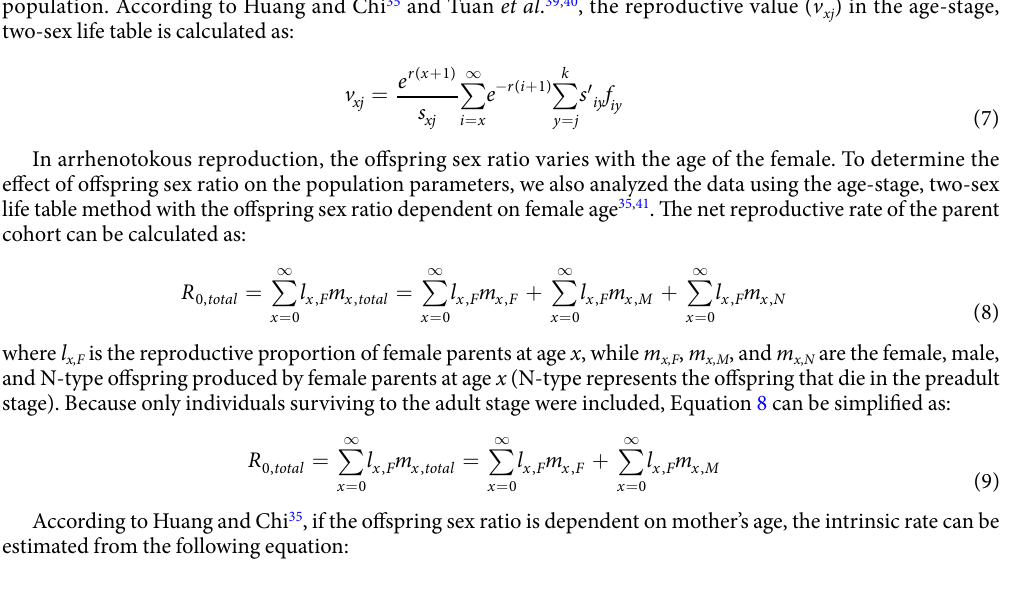
where ′ s is the probability that an individual of age x and stage j will survive to age i and stage y and is calculated iy , following the procedures described in 29 and Chi and Su 37 . According to Fisher 38 , the by assuming ′ = s 1 xj age-stage reproductive value ( v xj ) is defined as the contribution of an individual of age x and stage j to the future population. According to Huang and Chi 35 and Tuan et al . 39,40 , the reproductive value ( v xj ) in the age-stage, two-sex life table is calculated as: